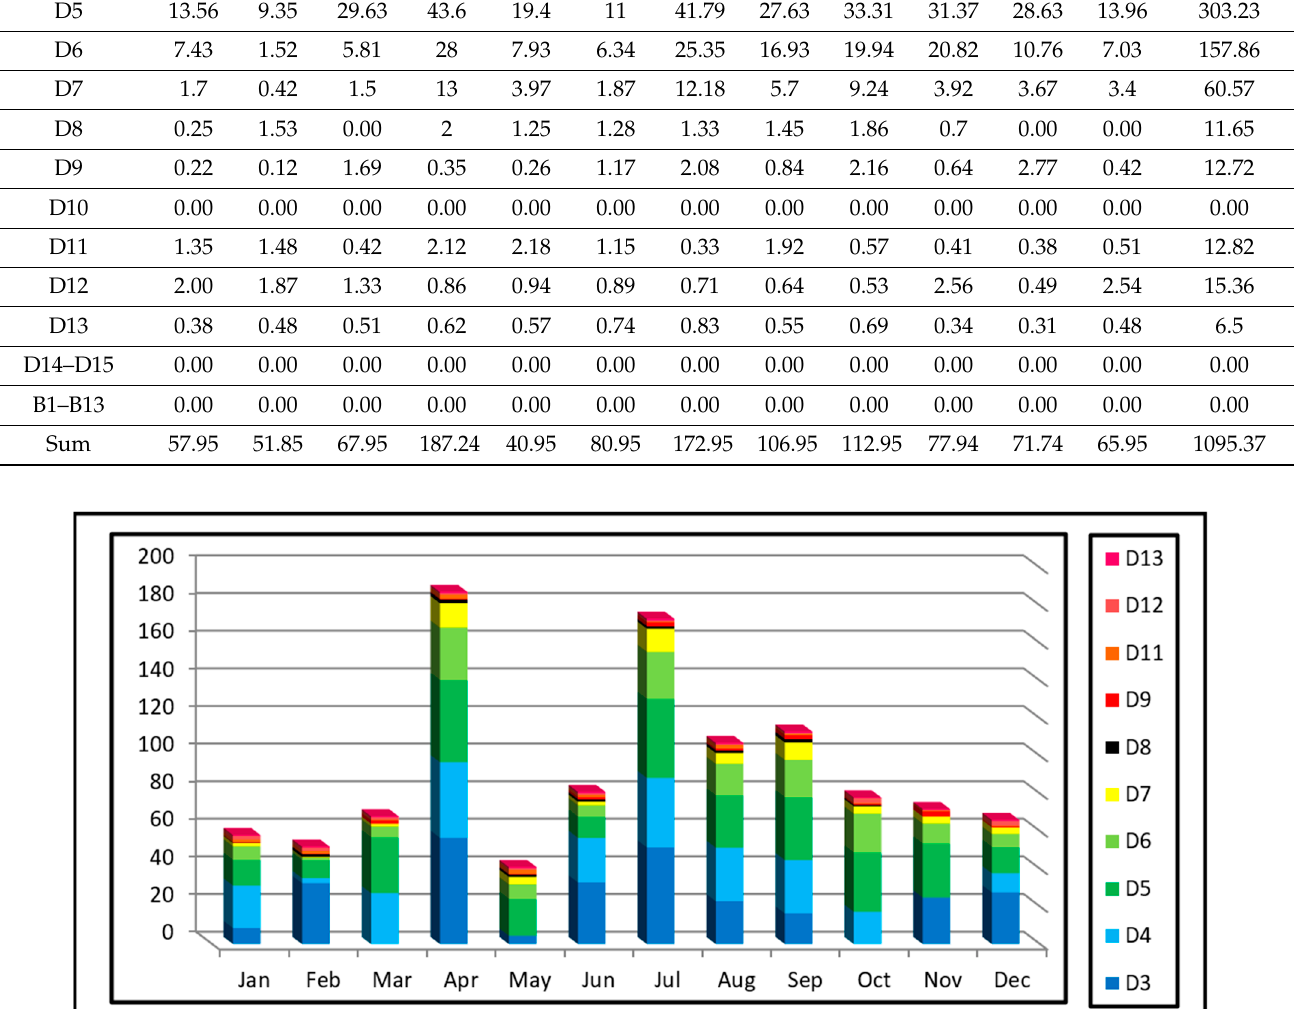
Figure 12. Location of DEMs which benefit from reused drainage water. 4.2. The Impact of Lining the Ismailia Canal A length of 56 km of the Ismailia Canal was found to be responsible for 21.06% of the total discharge of water losses. Therefore, the Ismailia Canal was considered to be the worst case in terms of seepage problems and erosion. The Ministry of Water Resources